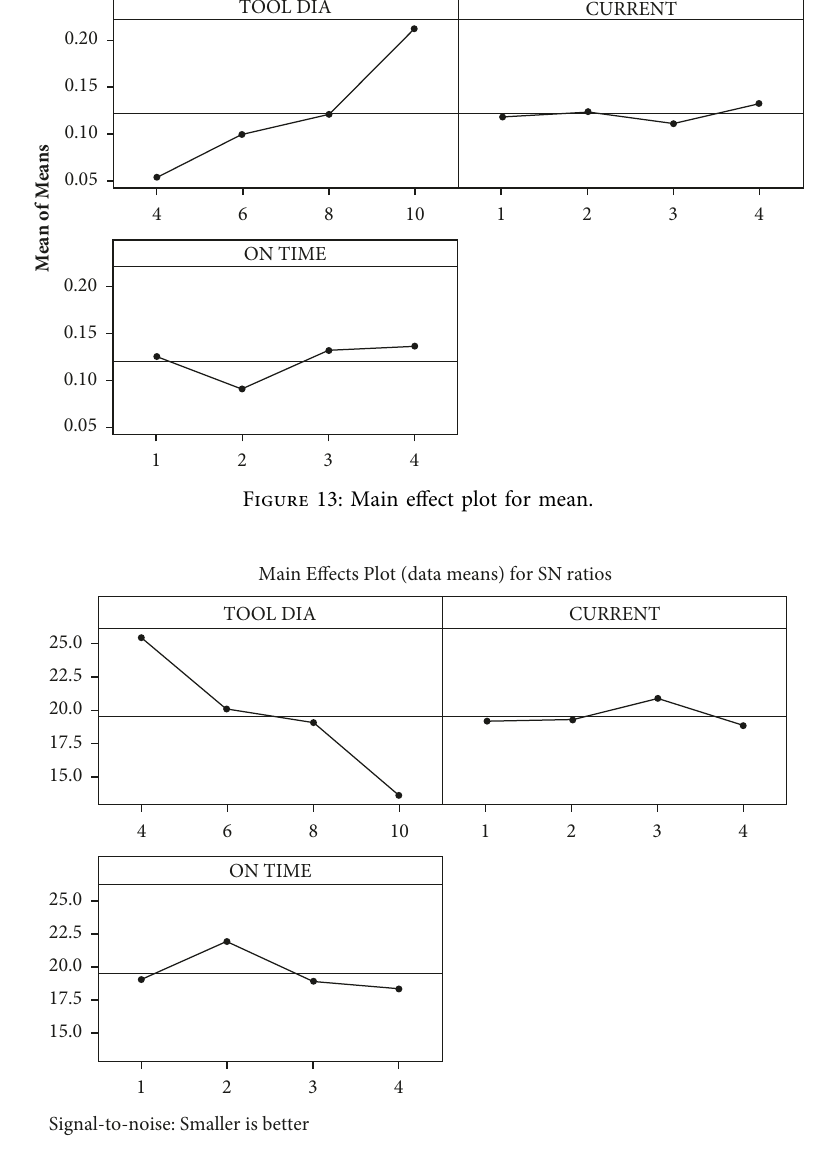
Figure 14: Main effect plot for S/N